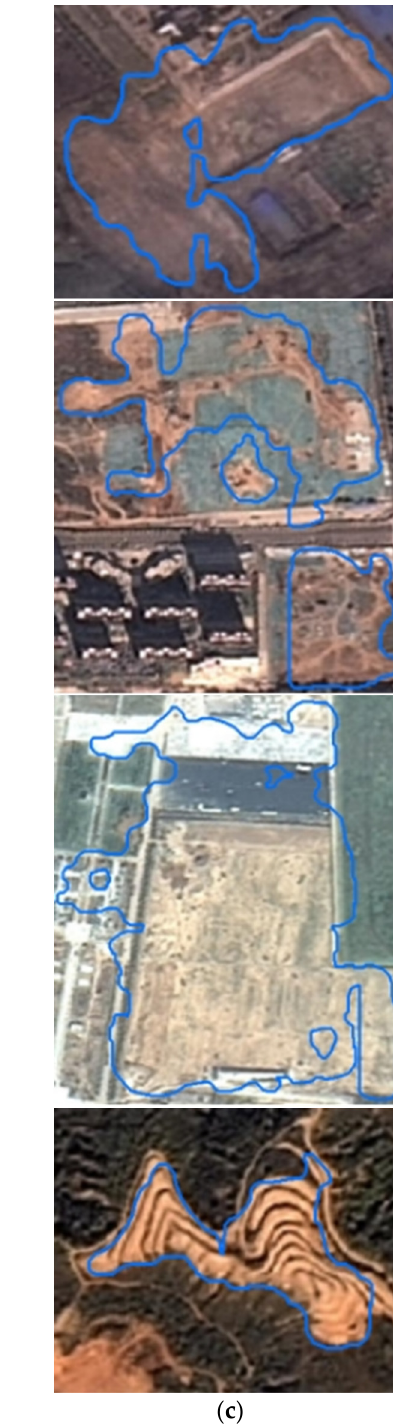
Figure 11. Post-processing results: ( a ) Original parcels on pre-temporal images. ( b ) Final results on post-temporal images. ( c ) ArcGIS results on post-temporal images.